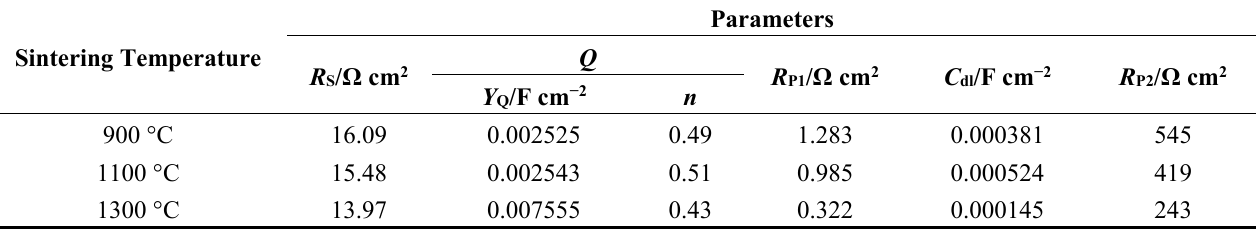
Figure 7. The equivalent circuit model used in the fitting of the obtained EIS data. Table 2. Electrochemical impedance spectroscopy parameters obtained for the different Al composites in the electrolytic 3.5% NaCl test